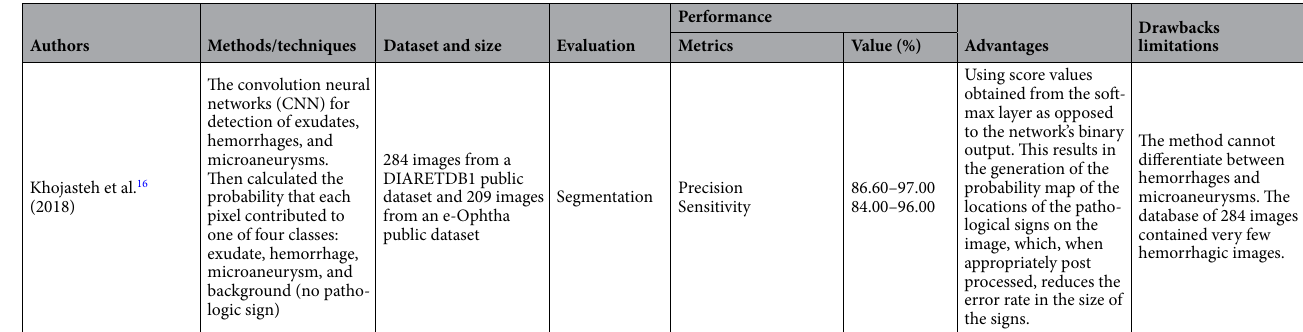
Table 1. A table summarizes the hemorrhage detection and segmentation techniques used in the literature. AUC is area under the ROC curve.